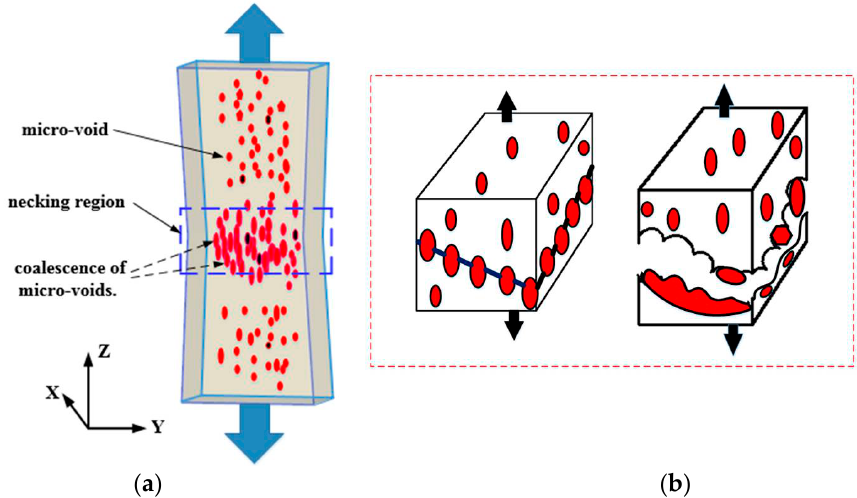
Figure 1. Physical aspect of ductile damage: ( a ) the microvoids coalescence and local necking occurs; and ( b ) damage evolution and macroscopic crack in the necked region.